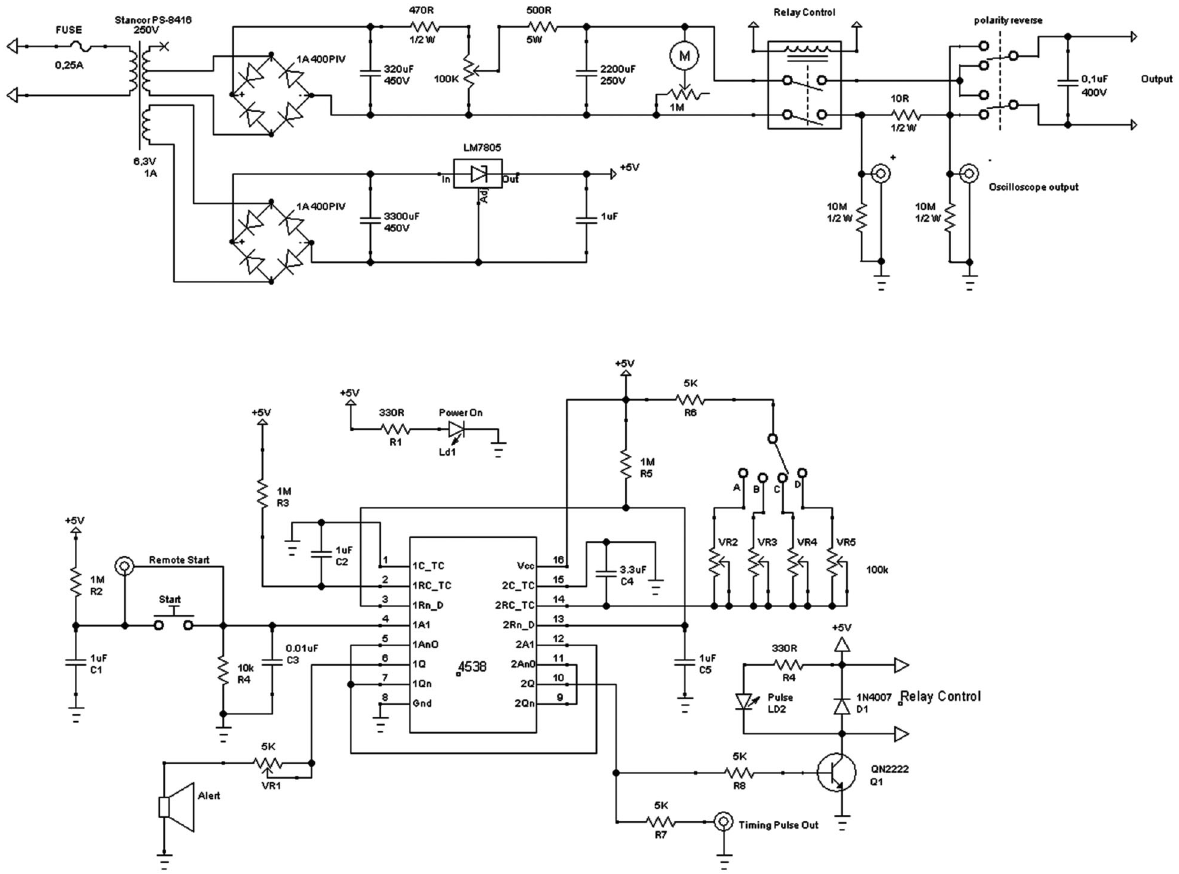
Figure 1. Electrical diagram for an in ovo